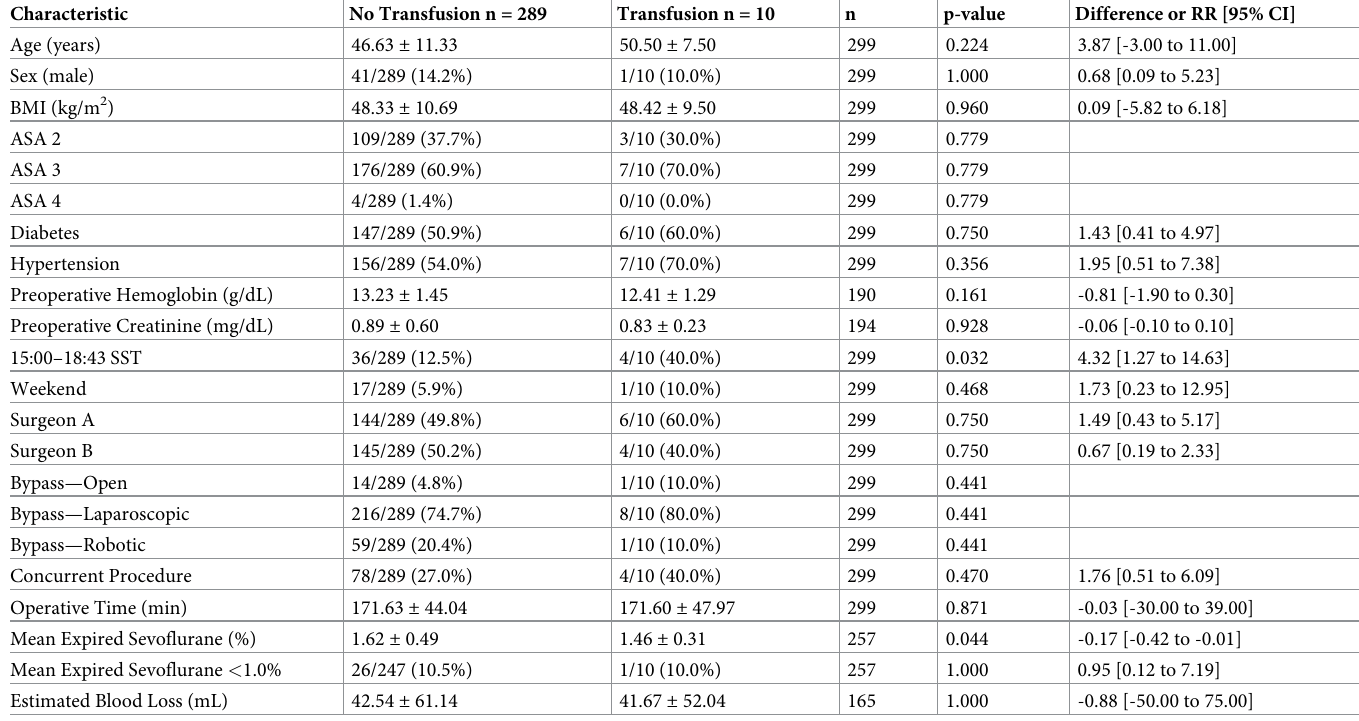
Table 2. Univariate comparisons between transfusion cohorts.